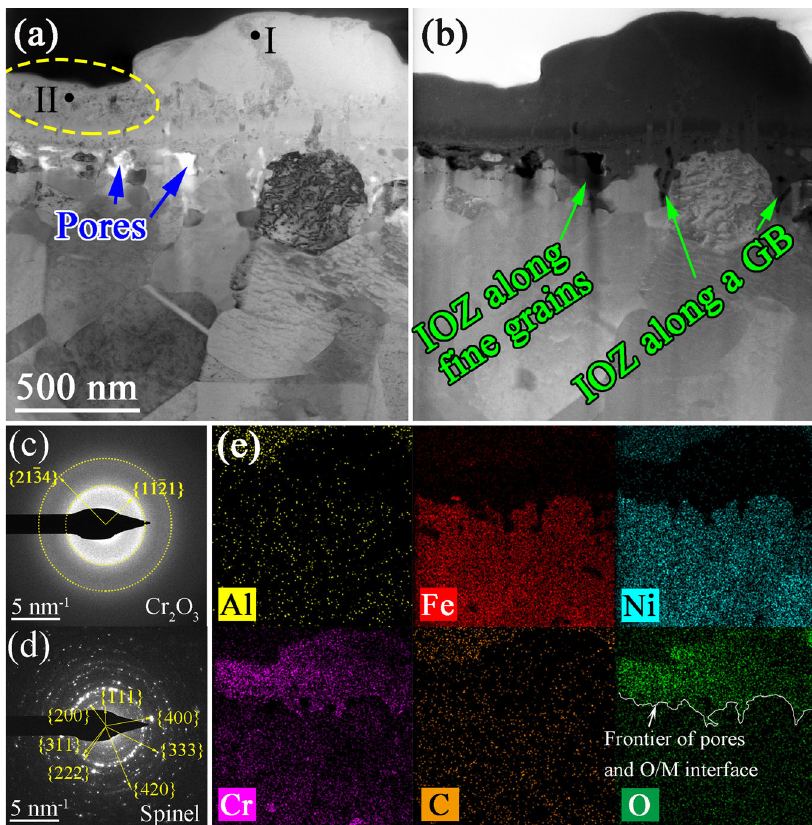
Fig. 5 TEM results of the surface oxide fi lm of A0 sample. a BF image, b HAADF image, c , d Nanobeam diffraction patterns of I and II regions, e EDS mapping of ( a ).